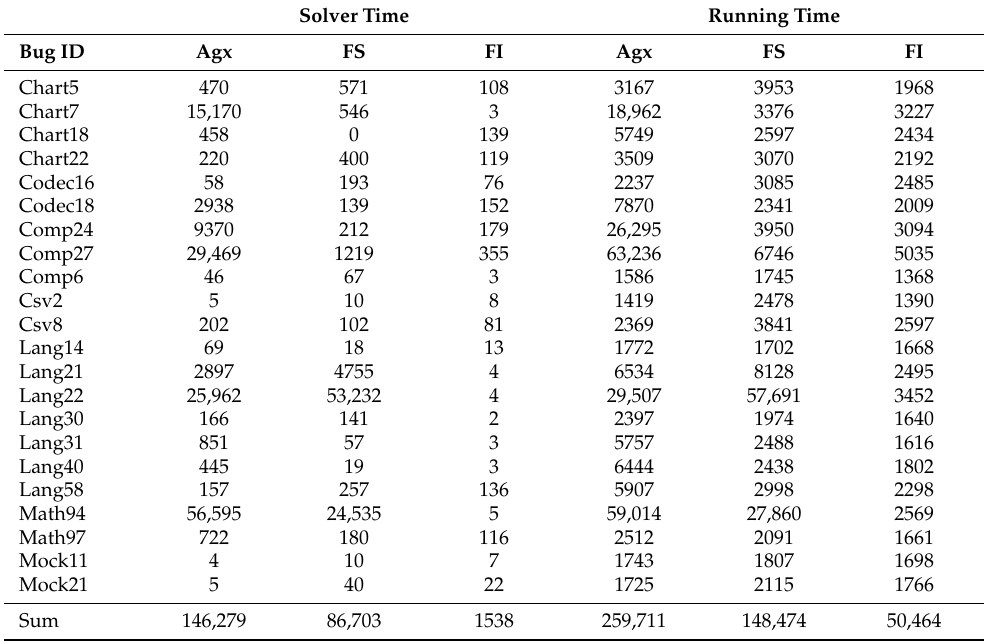
Table 6. Comparing execution time of AgxFaults (Agx), Single-path Control-Flow-Sensitive (FS), and Single-path Control-Flow-Insensitive (FI) approaches on real